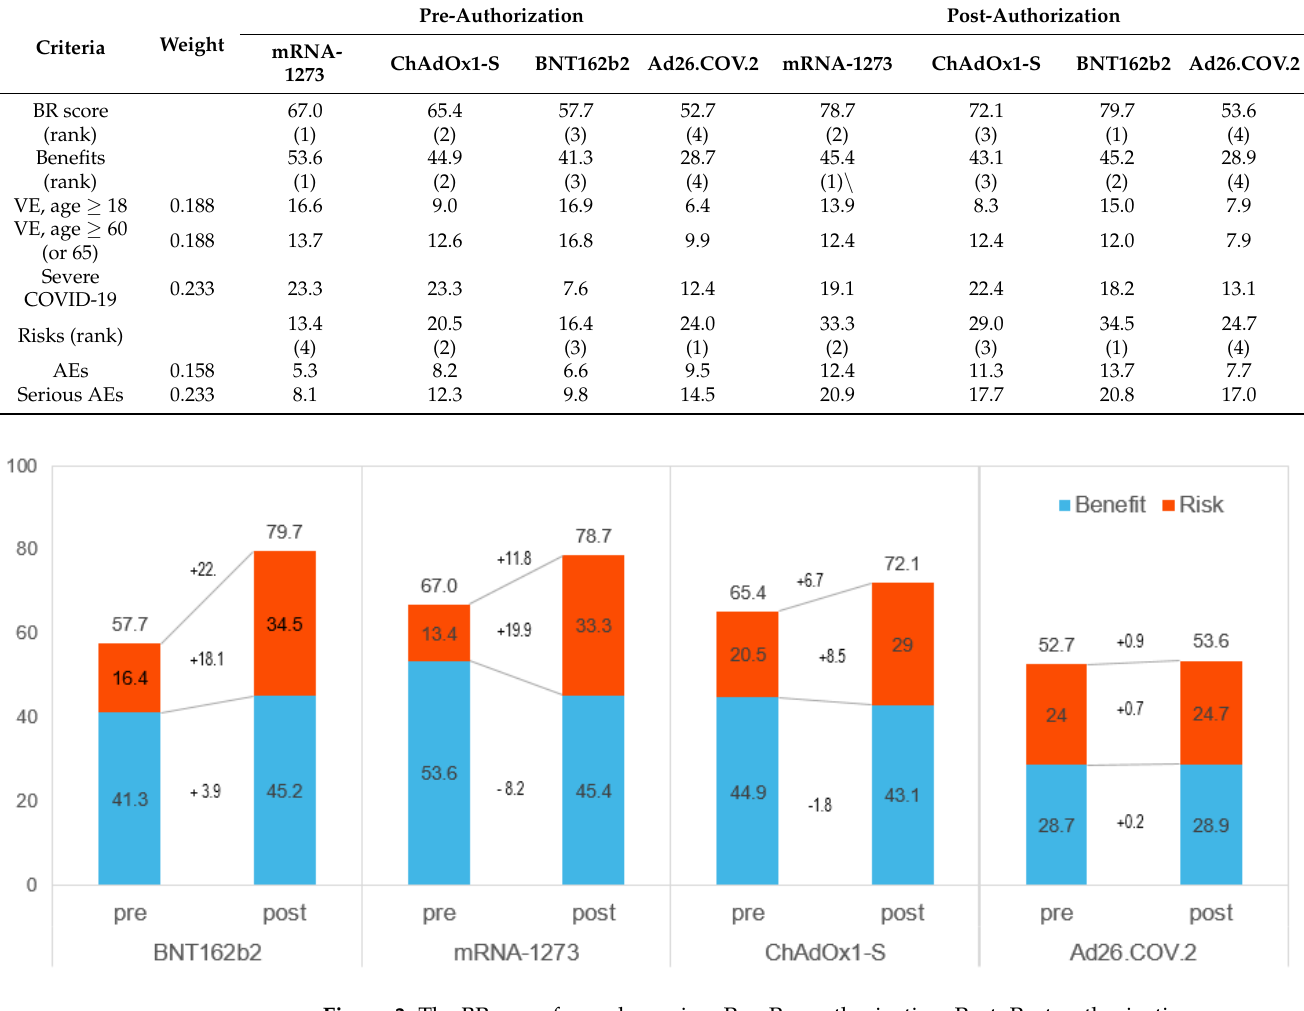
Figure 3. The BR score for each vaccine. Pre: Pre-authorization, Post: Post-authorization.